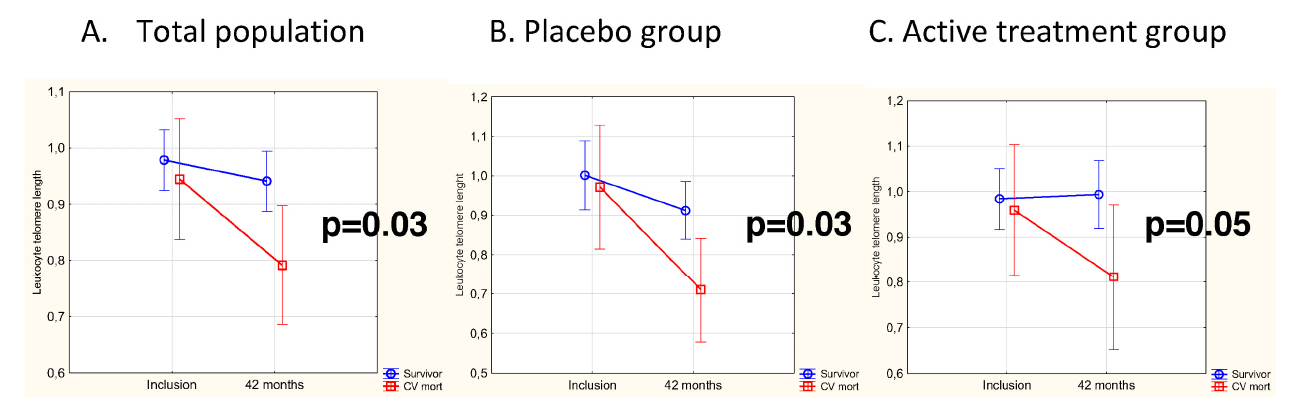
Figure 3. ( A ) LTL in the CV mortality group compared to survivors at baseline and after 42 months in the total population. Evaluation performed by use of repeated measures of variance. Current effect F(1,116) = 4.62, p = 0.03. Vertical bars denote 95% CI. The blue line represents the placebo group, the red line the active treatment group. ( B ) LTL in the CV mortality group compared to survivors at baseline and after 42 months in the placebo group. Evaluation performed by use of repeated measures of variance. Current effect F(1,49) = 5.30, p = 0.03. Vertical bars denote 95% CI. The blue line represents the placebo group, the red line the active treatment group. ( C ) LTL in the CV mortality group compared to survivors at baseline and after 42 months in the active treatment group. Evaluation performed by use of repeated measures of variance. Current effect F(1,65) = 3.96, p = 0.05. Vertical bars denote 95% CI. The blue line represents the placebo group, the red line the active treatment group.